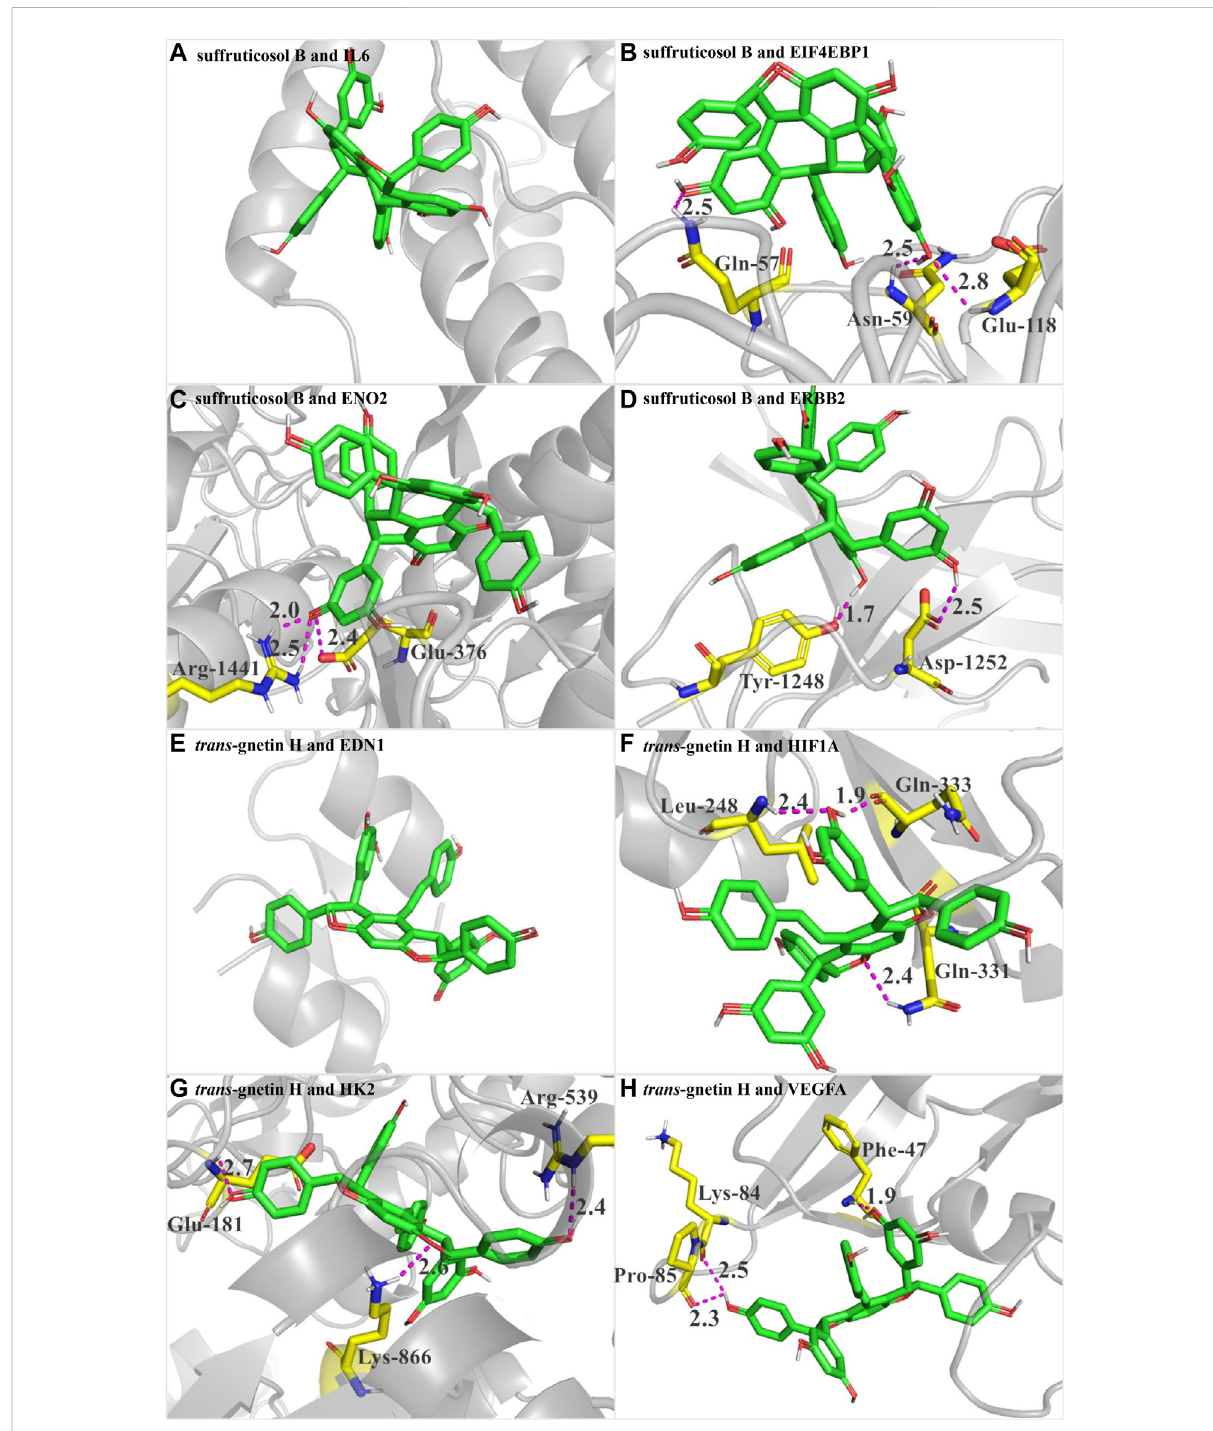
FIGURE 6 Interaction between SB and GH and target proteins in HIF-1 signaling pathway using molecular docking analysis. (A) the docking between suffruticosol B (SB) and IL6. (B) the docking between SB and EIF4EBP1. (C) the docking between SB and RNO2. (D) the docking between SB and ERBB2. (E) the docking between trans-gnetin H (GH) and EDN1. (F) the docking between GH and HIF1A. (G) the docking between GH and HK2. (H) the docking between GH and VEGFA. Took B for example, Figure B shows the docking between SB and EIF4EBP1. The green-based small molecule was compound SB, and the yellow-based molecule was the amino acid residue of EIF4EBP1 (Gln-57, Asn-59, Glu-118). Purple dotted line represented hydrogen bonding between SB and EIF4EBP1. SB formed hydrogen bonds with EIF4EBP1 through Gln-57, Asn-59, and